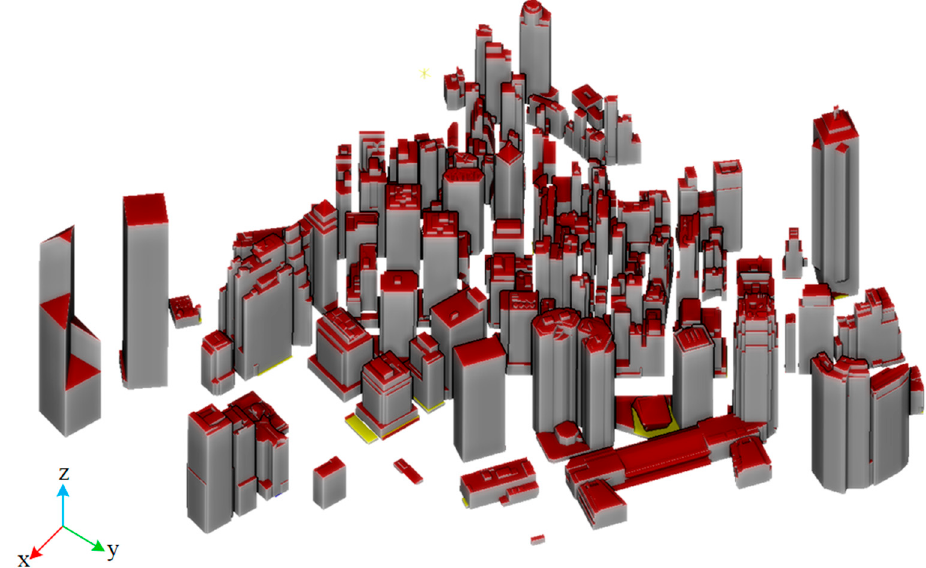
Figure 16. Reconstruction results of the 105 buildings in CityGML format. Red, grey, and yellow indicate roof, wall, and outer-floor surfaces, respectively.